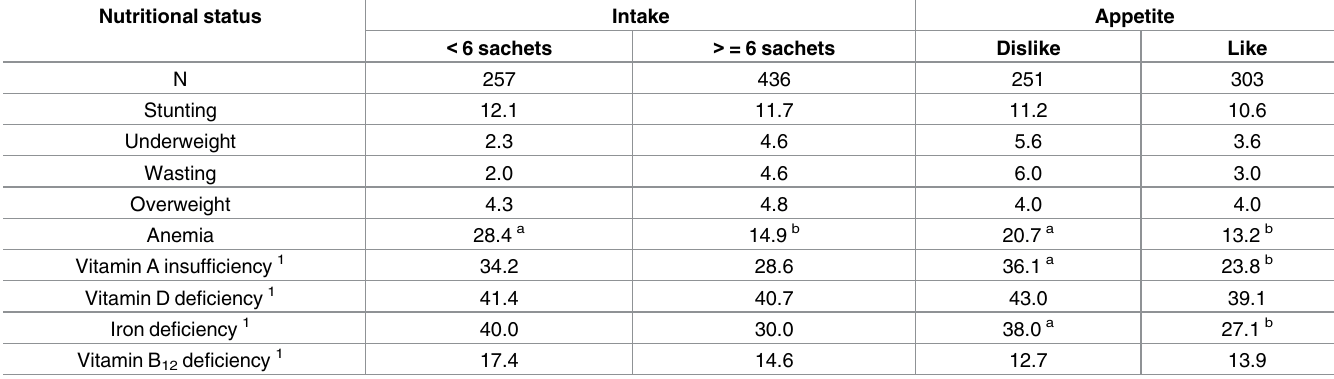
a Values without the same superscript letter are different at the P < 0.05 level. b Values without the same superscript letter are different at the P < 0.05 level. 1 Results from the children aged 12–23